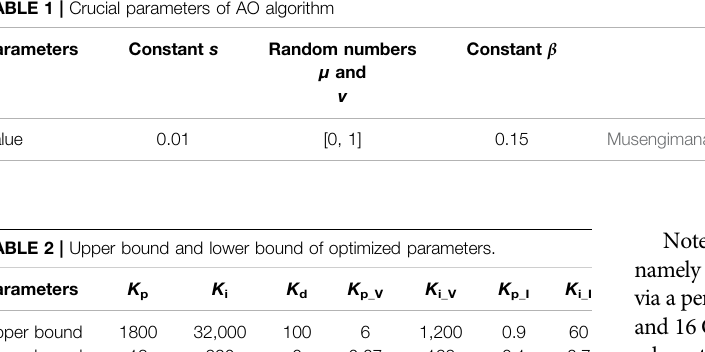
TABLE 1 | Crucial parameters of AO algorithm